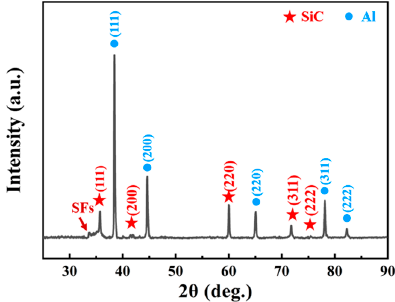
Figure 7. The XRD pattern of the SiCnws/6061Al composite.